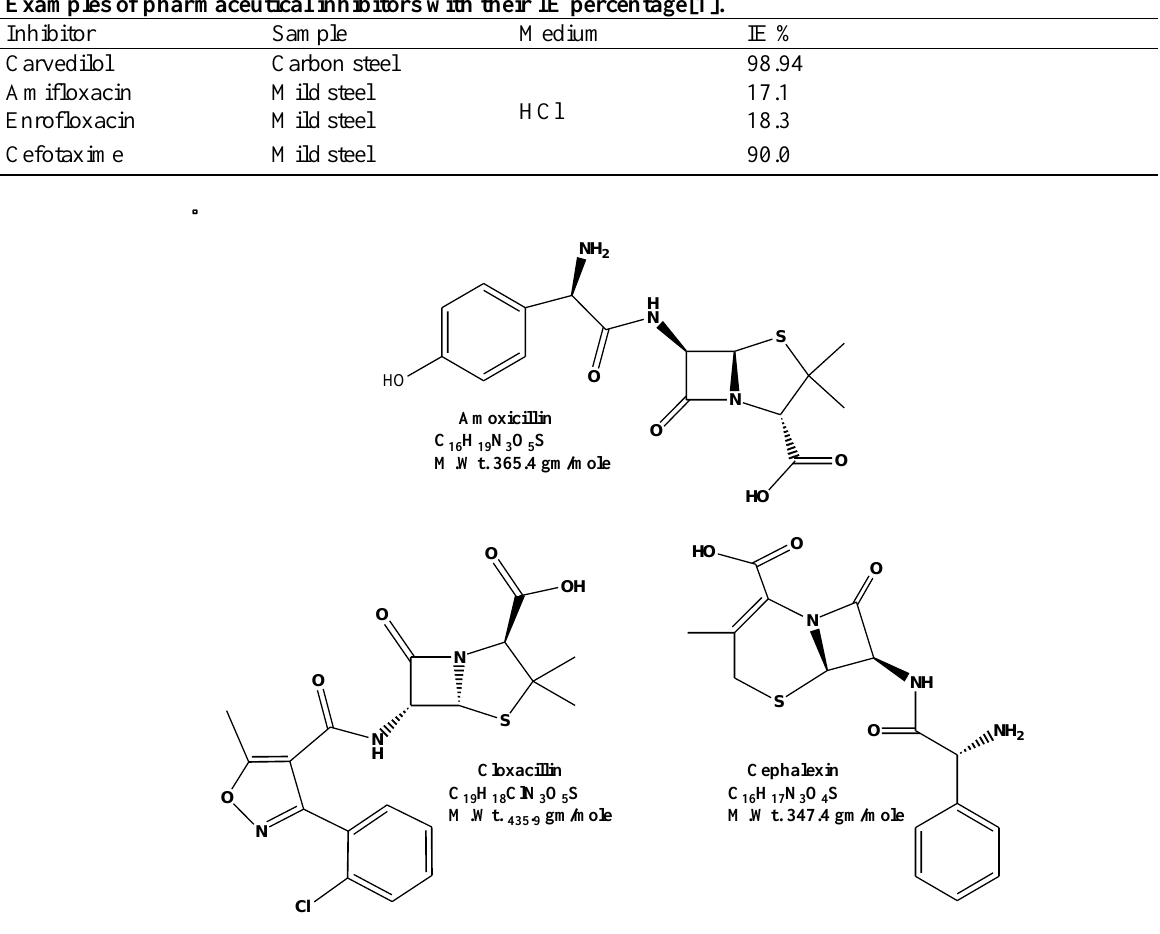
Fig.1. Chemical structure of the expired drugs used in the test with molecular weights for each